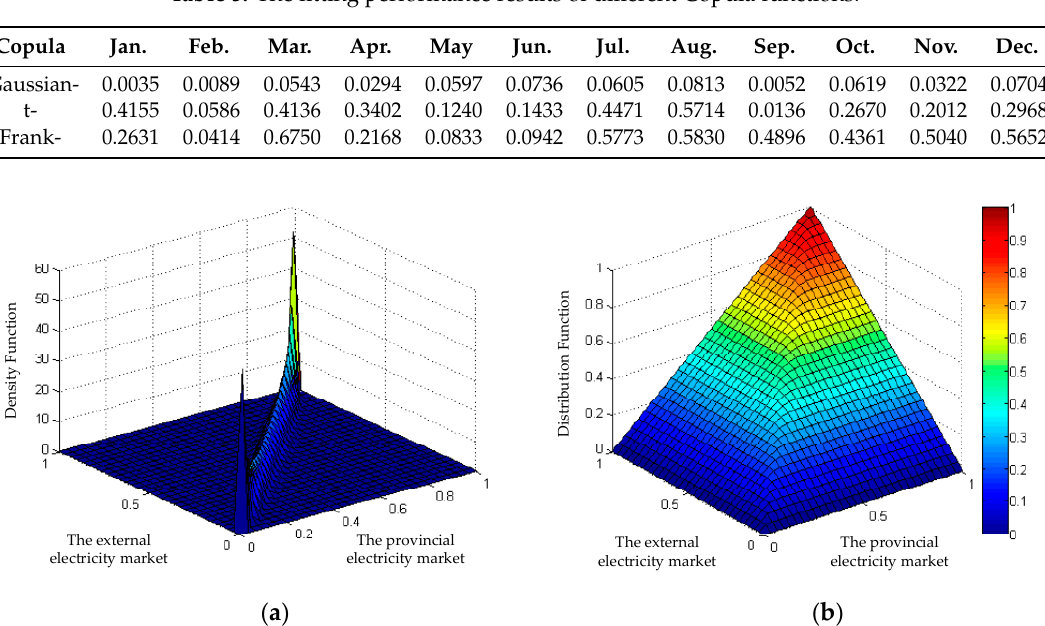
Table 3. The parameters of market clearing price (MCP) for market 1, 2 in a different month (yuan/MWh).